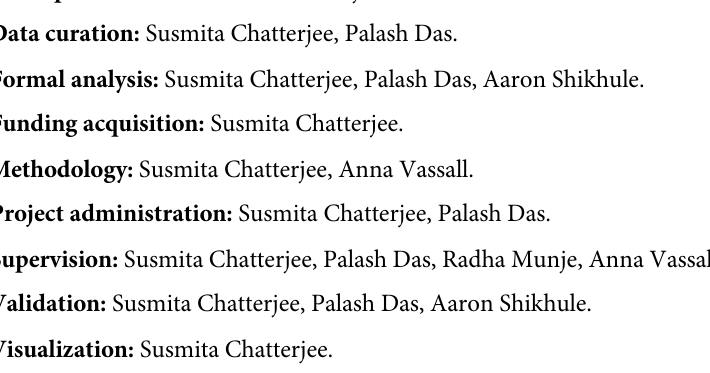
S5 Fig. Fitted line plots with amount of outstanding loan as dependent variable (urban slum dwellers, N = 104). S6 Fig. Fitted line plots with amount of borrowing / selling as dependent variable (urban slum dwellers, N =